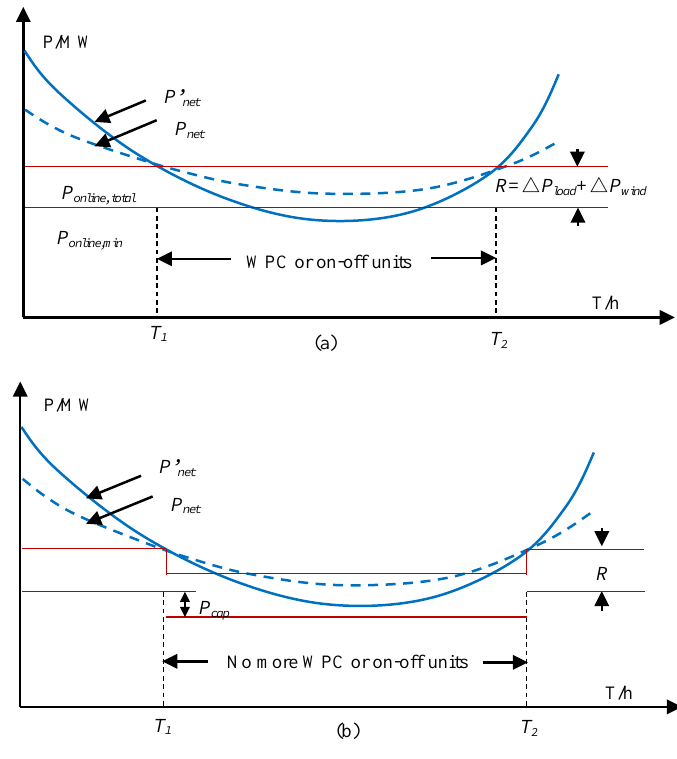
Figure 4. Schematic diagram of BESS making up the sparing reserve of the wind power uncertainty; ( a ) wind power integration without BESS; and, ( b ) wind power integration with BESS.